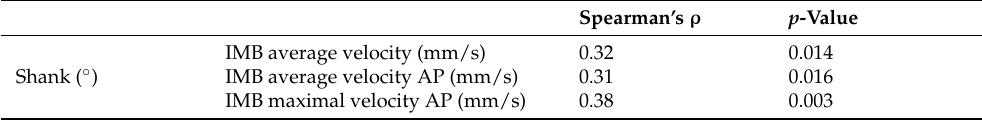
Table 5. Correlation between the shank angle and gait initiation measurements. Only significant partial correlations between postural angles and gait initiation measurements corrected for the influence of the group variable are shown (Spearman’s ρ , p -value < 0.05). No correlation was significant after Bonferroni correction for multiple comparisons.